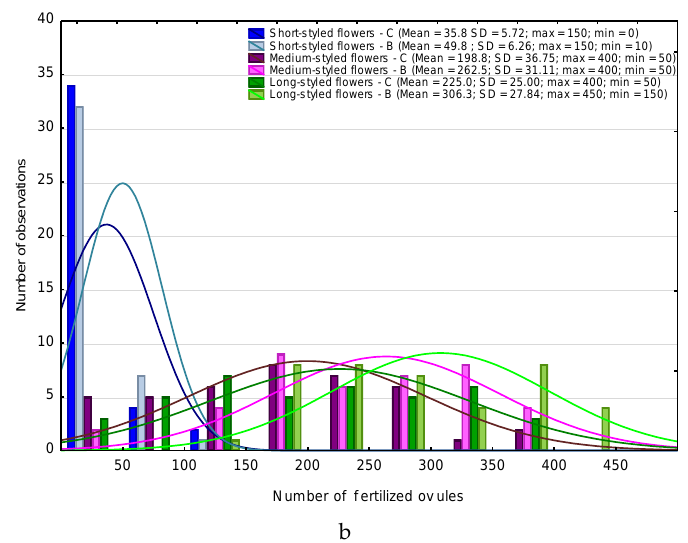
Figure 5. Number of pollen tubes ( a ) and fertilised ovules ( b ) in the styles of different flower types in “ Epic ” F 1.